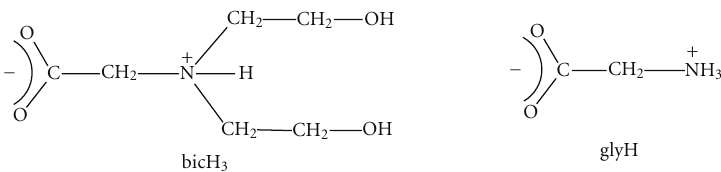
Scheme 1: Formulae of N , N -bis(2-hydroxyethyl)glycine (bicine; bicH 3 ) and glycine (glyH) discussed in the